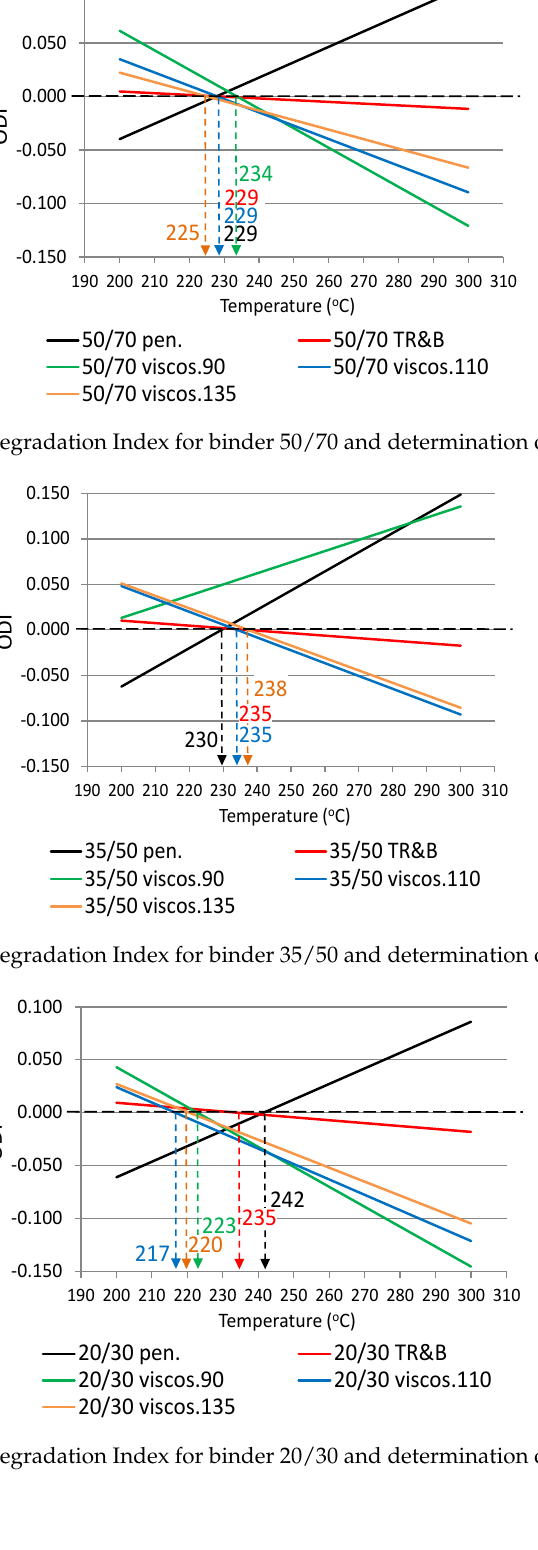
Figure 6. Overheating Degradation Index for PMB65/105-60 and determination of temperature T (ODI) . Figure 7. Overheating Degradation Index for binder PMB45/80-55 and determination of temperature T (ODI) .